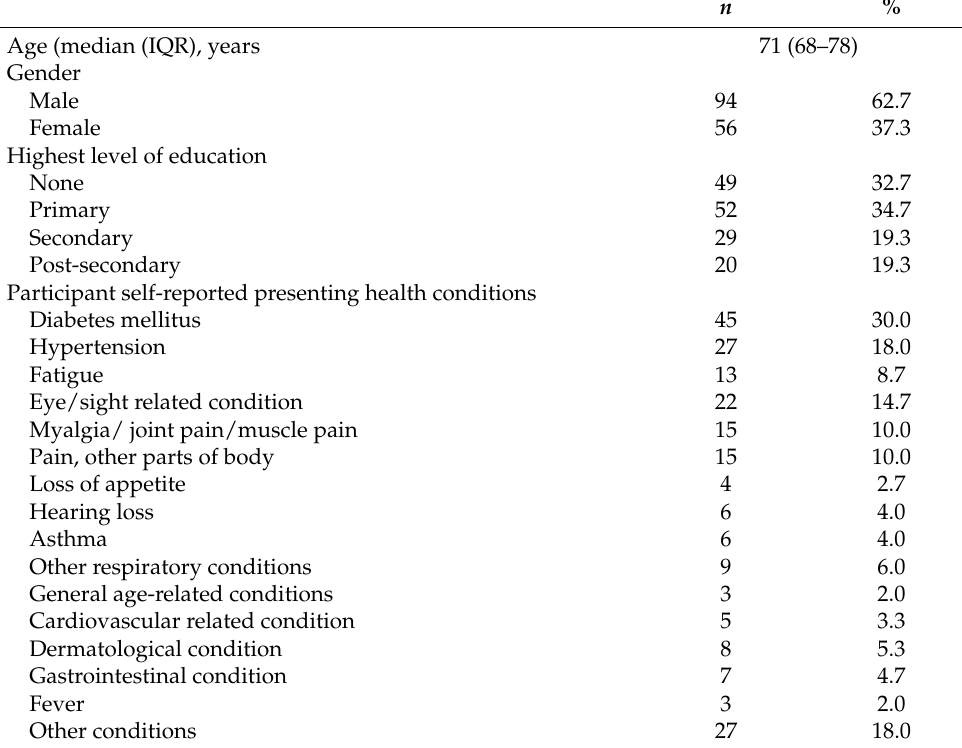
Table 1. Demographic and health characteristics of survey